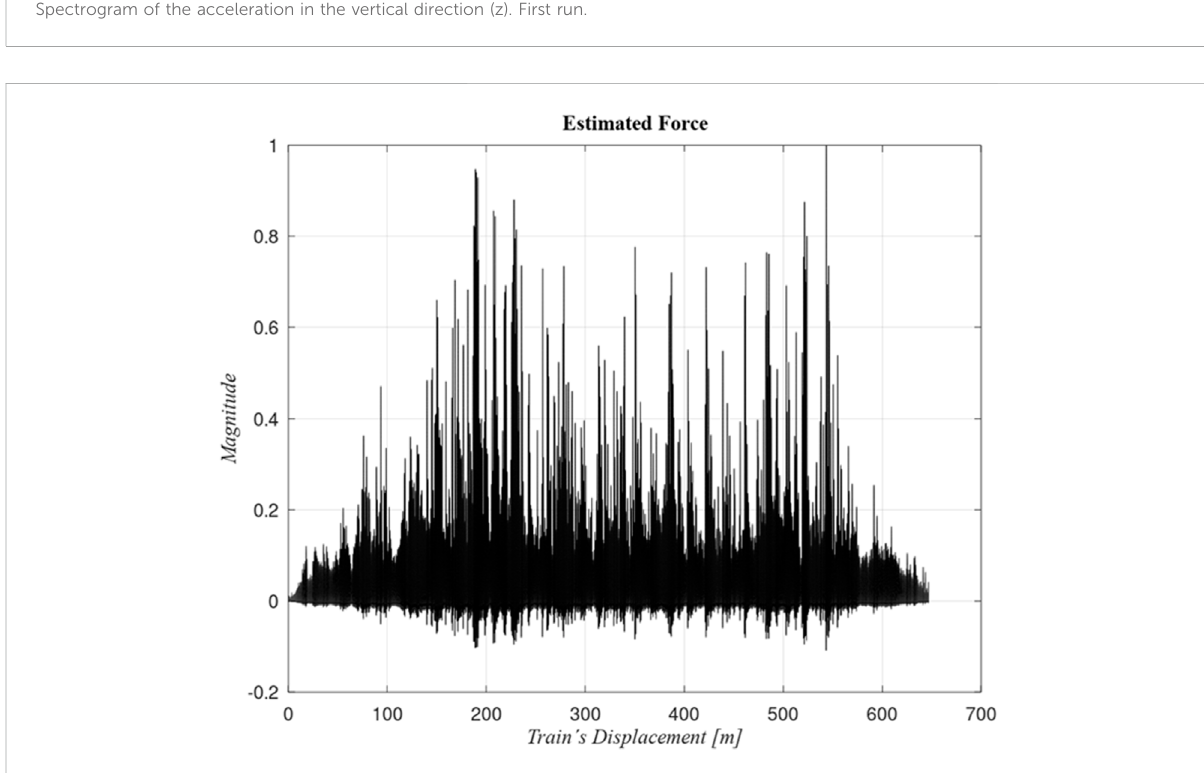
FIGURE 12 Estimated track deformations between stations A and